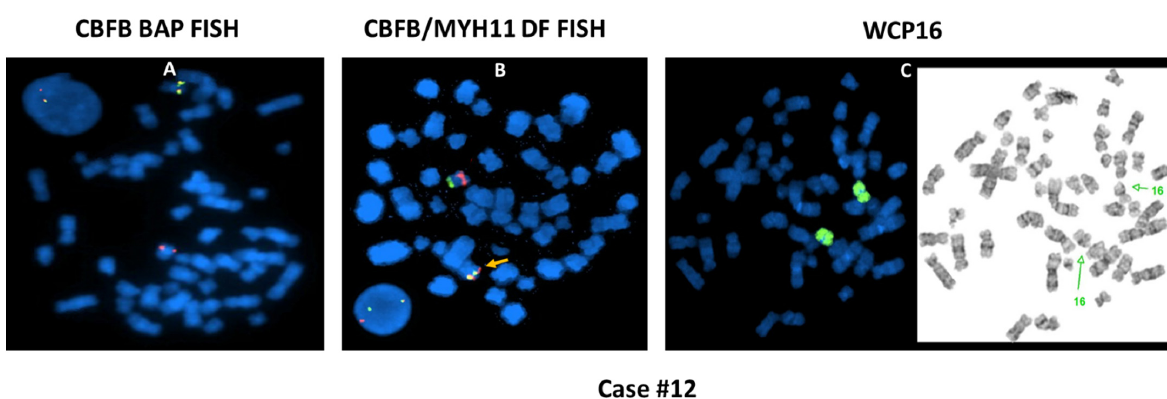
Figure 4. Illustration of cryptic and complicated CBFB-MYH11 rearrangement in case #12: atypical FISH signal pattern (1R1F, A ) by BAP FISH; one fusion signal (1R1G1F, B ) by DF FISH. Whole chromosome 16 painting (wcp16) ( C ) excluded a possible recombination between one chromosome 16 and a non-16 chromosome.